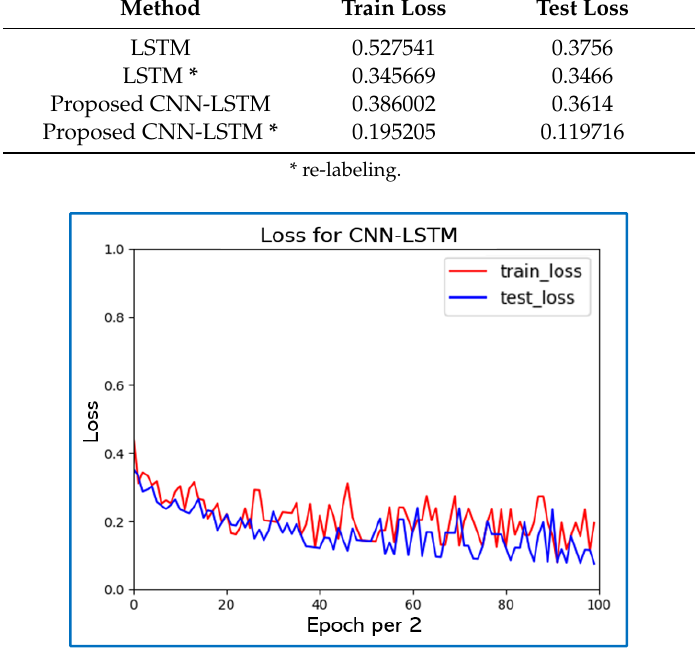
Figure 15. Train loss by CNN-LSTM after FFT (Fast Fourier Transform) at 1000 Hz and interpolation.